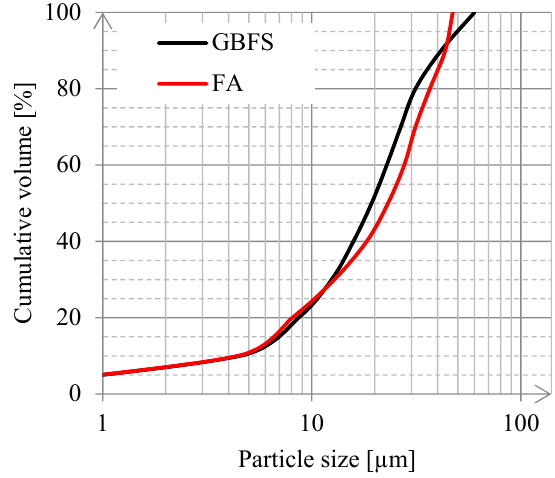
Figure 2. Particle size distributions of GBFS and FA as measured with a laser diffraction analyser.